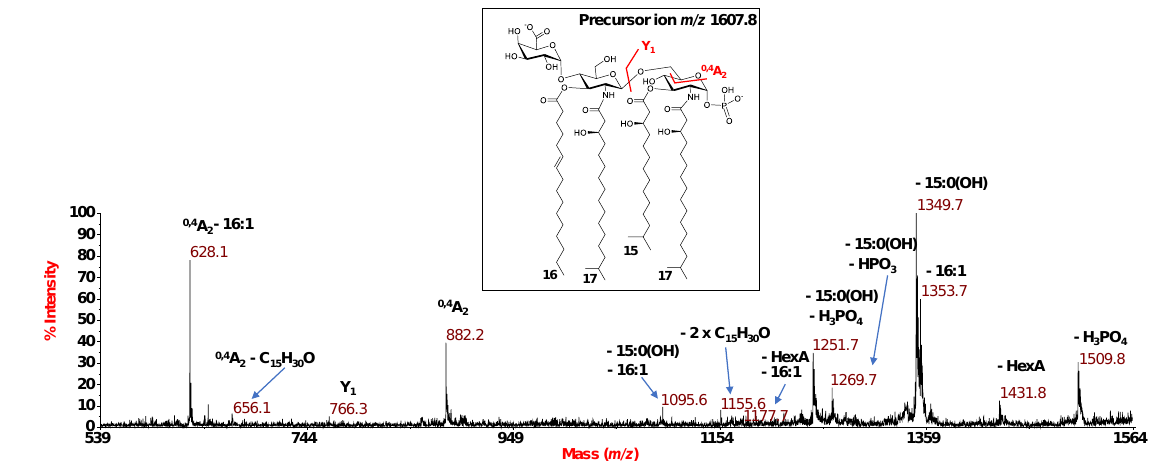
Figure 2. Negative-ion MALDI MS/MS spectrum of precursor ion at m / z 1607.8, a representative ion peak of the cluster ascribed to tetra-acylated lipid A species from E. pacifica KMM 6172 T . The assignment of main fragments is reported in the spectrum. The proposed structure for the lipid A species is reported in the inset, where the representation of 15:0(3-OH) in its branching form is tentative. In addition, since both the phosphate group and the HexA unit may be candidates to hold the charge, the proposed structure has been sketched carrying two negative charges for information purposes only. Peaks originating from the loss of C 15 H 30 O (226 mass units), due to the rearrangement occurring on amide-linked 3-OH acyl chains having the hydroxyl group free, have been also